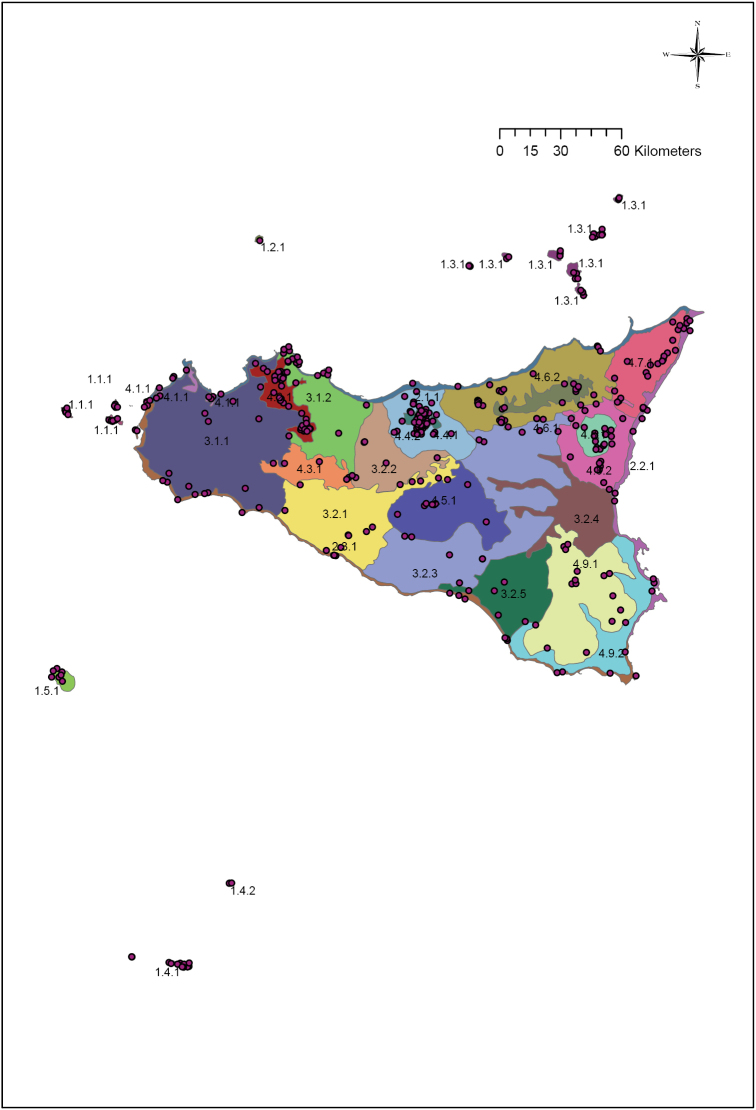
Projection on the sub-units of the loci classici of the Italian endemics described from Siciliy (Brundu et al. 2017).